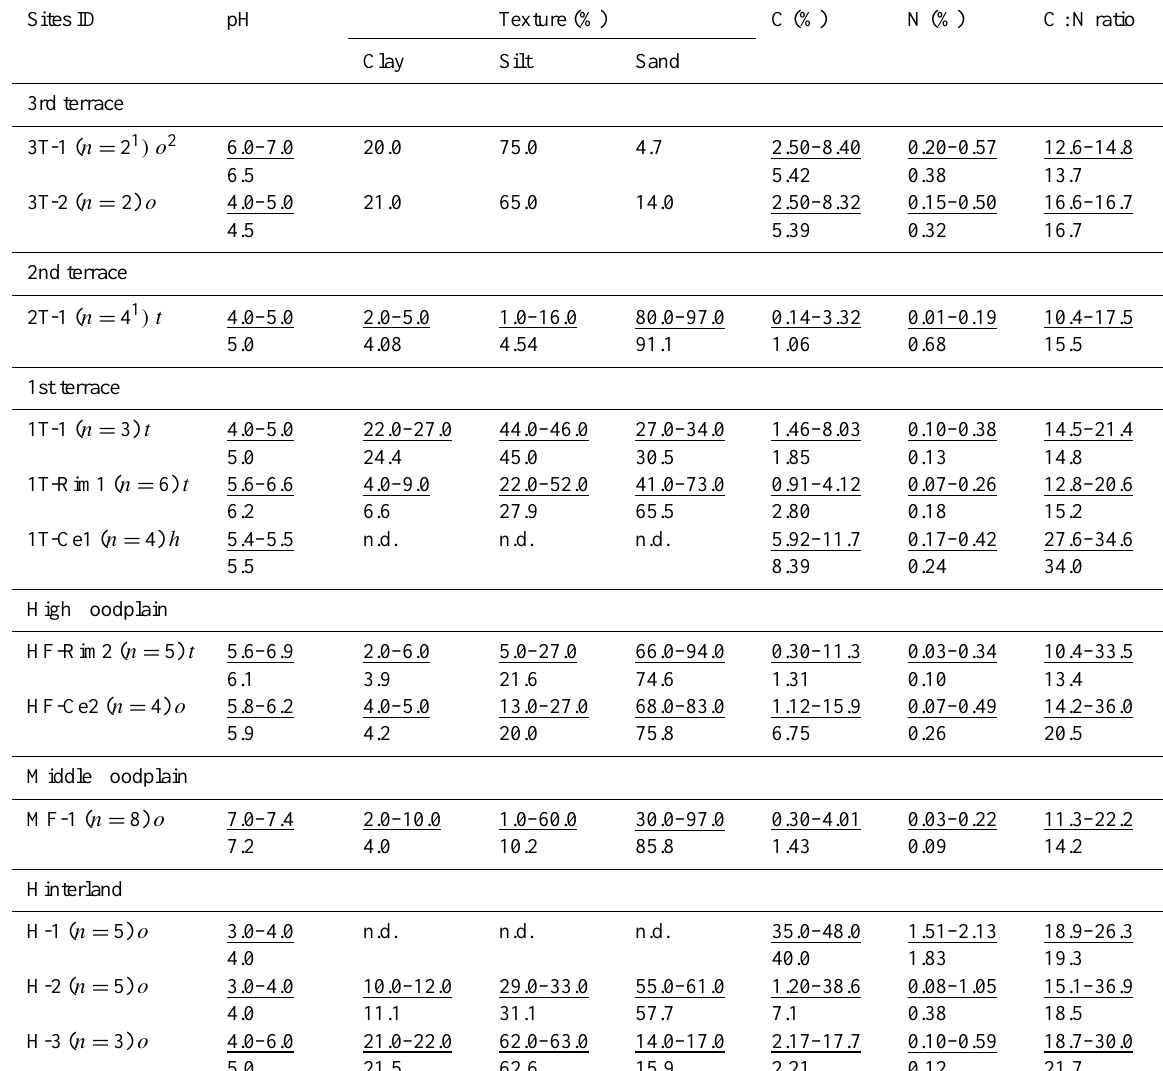
Table 3. Min–max range (numerator) and median values (denominator) of standard soil characteristics of all studied units along the north– south